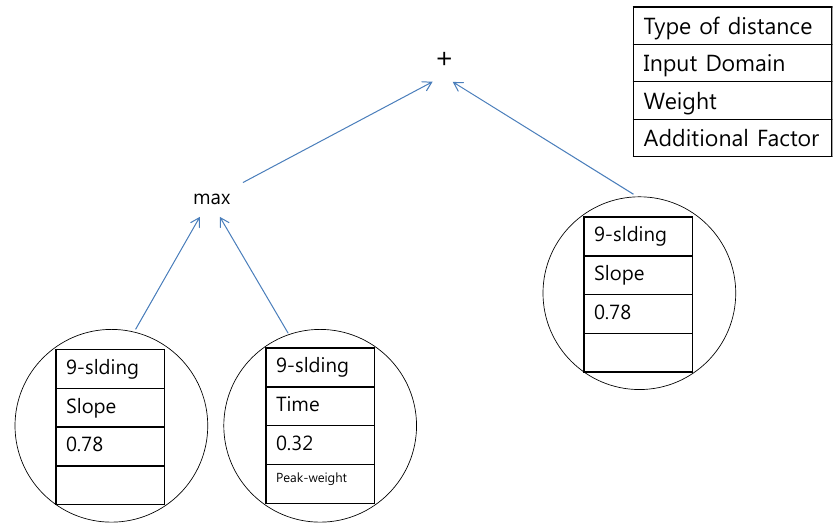
Figure 19. Proposed tree for the southern region using the data of experts #1 and #2.